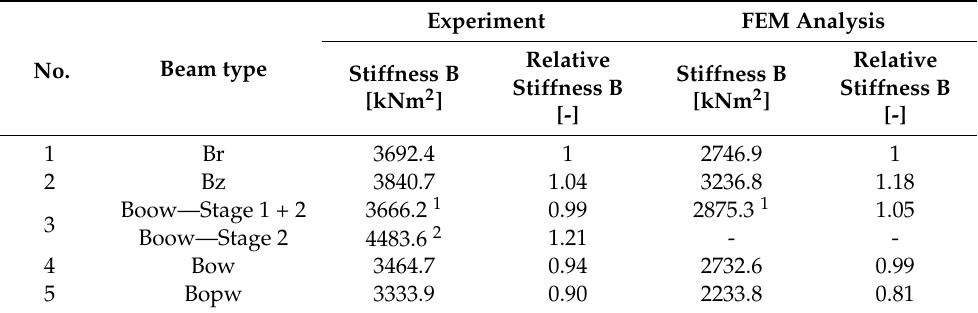
Table 9. Stiffness and relative stiffness of beams strengthened using CFRP strips in comparison with reference beam at load of 60 kN (which corresponds to design load-carrying capacity of reference beam) based on experimental and numerical